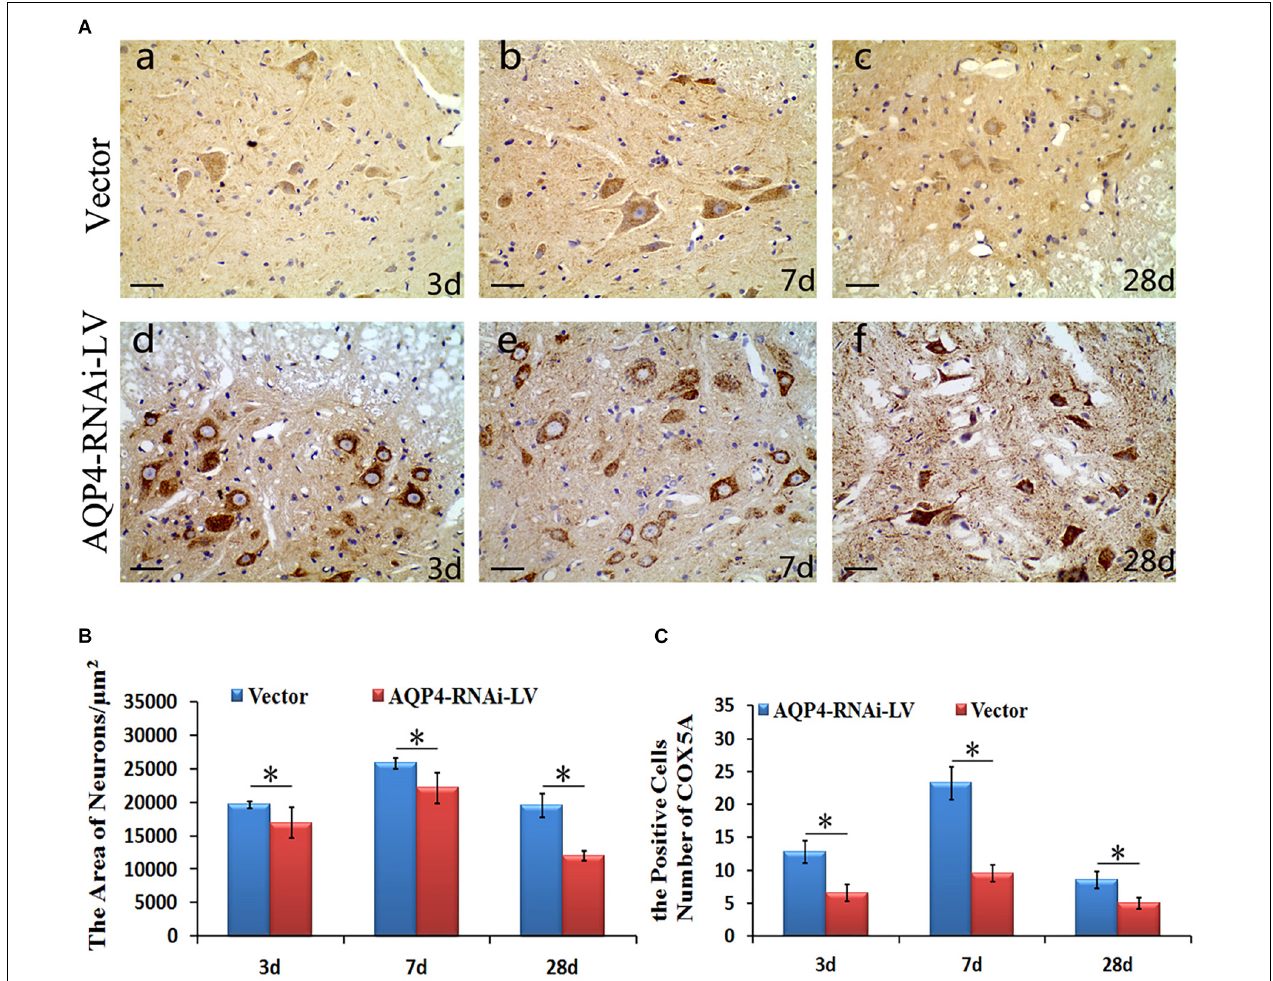
FIGURE 5 | Localization and expression of COX5A and effect of AQP4 inhibition in SCC. (A) IHC staining determined the localization of COX5A (brown) in motoneuron mainly following AQP4-RNAi lentivirus transduction. Black arrows mark COX5A. The group of AQP4-RNAi-LV had more obvious COX5A-positive products in motoneurons than the vector groups at 3, 7, and 28 days after SCC. Moreover, at 7 days as well as 28 days, there was a significant loss of COX5A-positive products in both the vector and AQP4-RNAi-LV groups. (B) The area of neurons in the AQP4-RNAi group was smaller than the vector groups at 3, 7, and 28 days after SCC. ∗ denotes P < 0.05, compared with vector groups. (C) The cell numbers of COX5A expressed in the AQP4-RNAi groups and the vector groups are shown. All of the AQP4-RNAi groups were higher than vector groups. ∗ denotes P < 0.05, compared with Vector